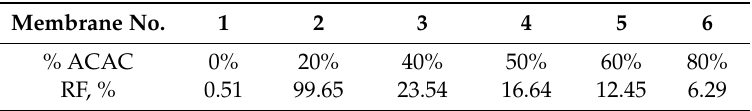
Table 2. Recovery factors (RF) for competitive transport of Zn(II) ions across polymer inclusion membranes (PIMs) with acac as a carrier. Membrane: PVC, 10% DAO, and acac. Feed phase: cZn(II) = 5 mM, pH = 9.62; receiving phase: water. Membrane No.